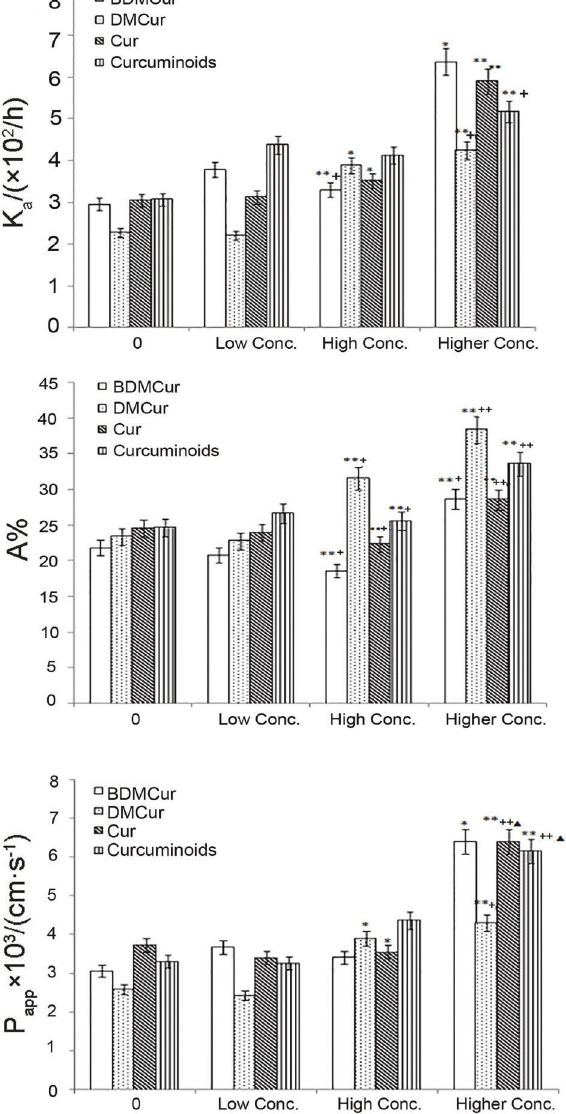
Figure 5. In fl uence of different verapamil hydrochloride concentra- tions on absorption parameters of bisdemethoxycurcumin (BDMCur), demethoxycurcumin (DMCur) and curcumin (Cur). Top : absorption percentage (A%); middle : drug apparent absorption coef fi cient (P app ), and bottom : absorption rate constant (K a ). Conc: concentration. **P o 0.01, *P o 0.05 compared to medicine group without inhibitor; mm P o 0.01 compared to medicine group with low concentration of inhibitor (ANOVA). upon intestinal absorption for various constituents is shown in Figure 6. In fl uence of energy inhibitor 2,4-dinitrophenol on drug absorption Compared with the group without inhibitor, the A% of BDMCur, DMCur, DMCur and curcuminoids of the group